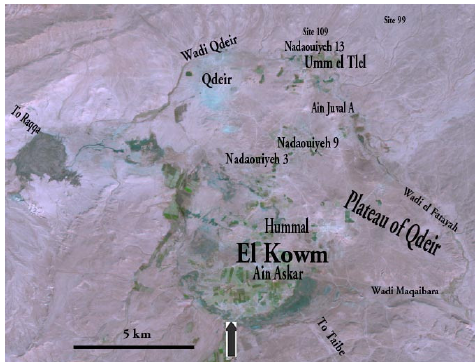
Figure 5. Prehistoric sites in the El Kowm basin displayed on a Landsat-7 ETM image. Mapping on Landsat-7 ETM image by M. Lönnqvist 2009, basing information on Besançon et al. , 1981.